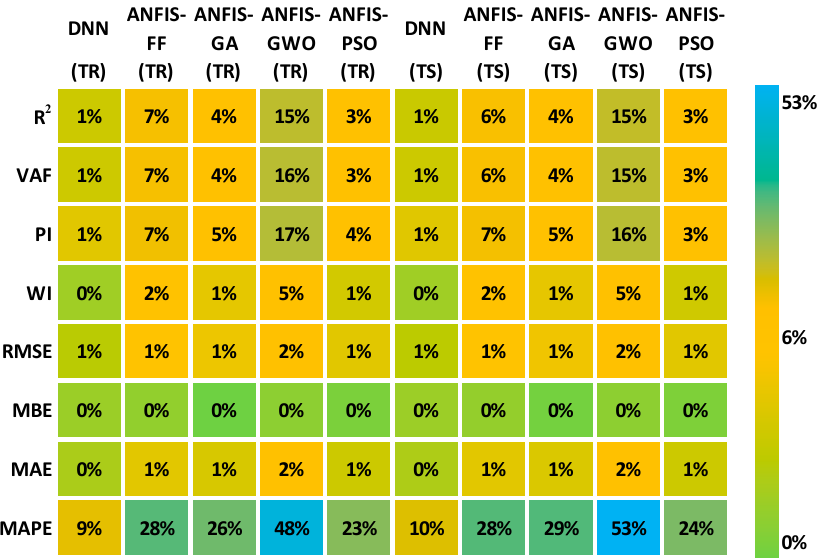
Figure 17. Error matrix for longitudinal ( y ) direction (TR for training and TS for testing).